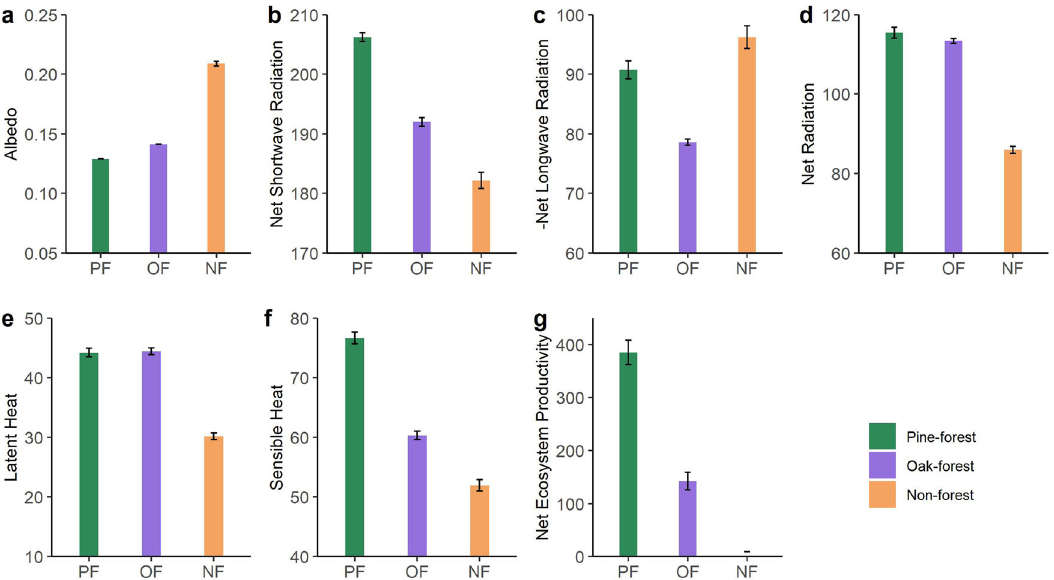
Fig. 3 Land cover type effects on the annual means (2000 – 2015) of radiative and non-radiative fl uxes. Annual mean of Albedo ( a ), Net Shortwave Radiation (SWnet in W m − 2 ; b ), − Net Longwave Radiation ( − LWnet in W m − 2 ; c ), Net Radiation (Rn in W m − 2 ; d ), Latent heat fl ux (LE in W m − 2 ; e ), Sensible heat fl ux (H in W m − 2 ; f ), and an annual sum of Net Ecosystem Productivity (NEP in gC m − 2 yr − 1 ; g ). Oak-forest (OF, purple bars) values compared with Aleppo Pine-forest (PF, green bars) and non-forest (NF, orange bars) averaged from multi-year annual means of the semi-arid and dry- subhumid paired sites. The paired t-test was used to compare multi-annual averages of all variables between forested and adjacent non-forested sites and between sites across the climatic gradient. The error bars are for ± standard errors of the means.